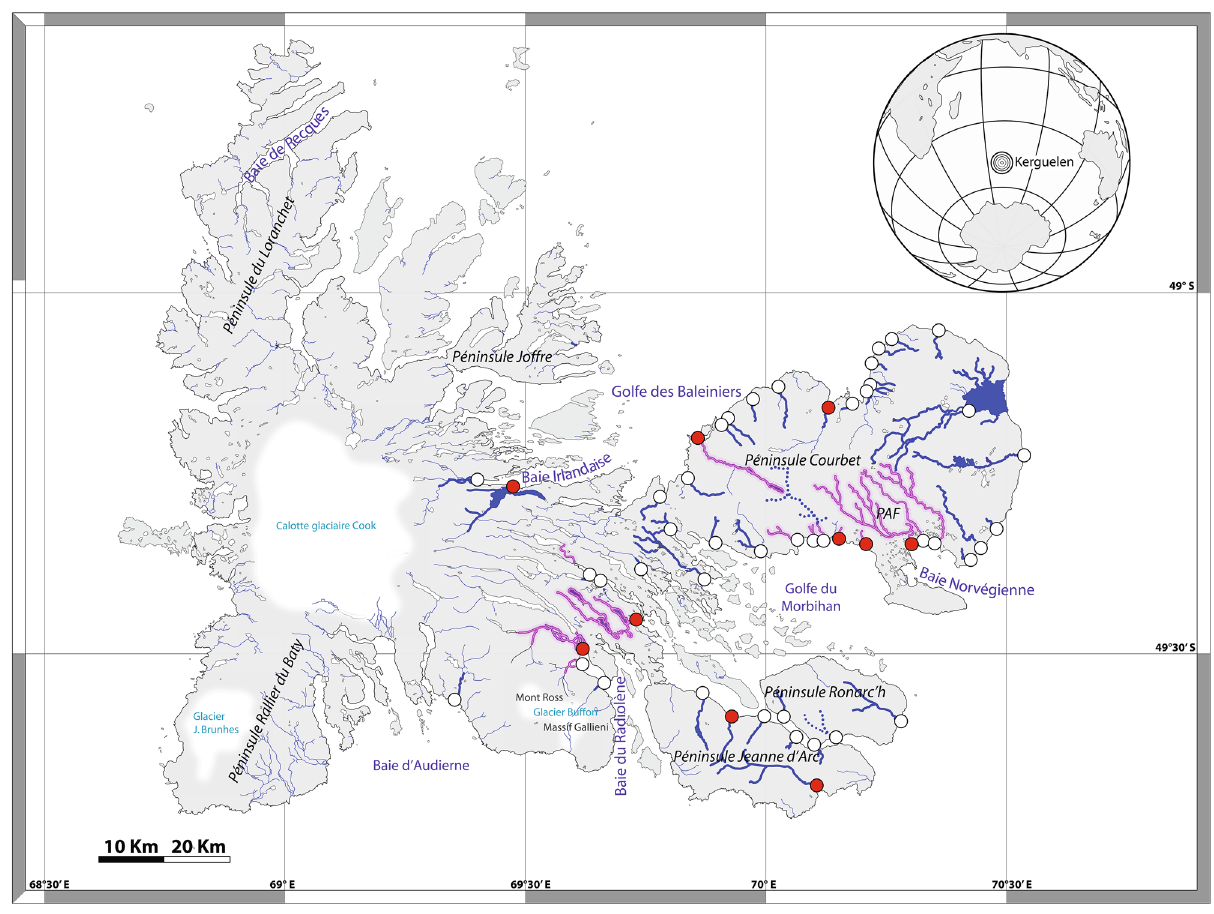
Figure 1. Map of Kerguelen Islands displaying the current distribution area of brown trout. The rivers with a thin blue line are still fishless, those with a blue bold line are populated only by Salmo trutta , those with a maroon bold line are populated by Salmo trutta and at least one other species ( Salvelinus spp or Salmo salar ), and those with a dotted line are populated only by Salvelinus . Red dots: locations where brown trout were released by humans. White dots: locations where brown trout introduced naturally. Map obtained with permission from 91